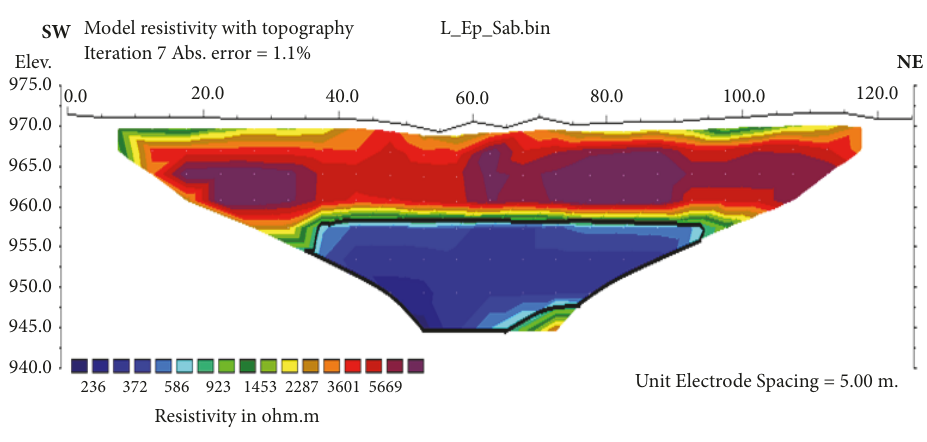
Figure 6: Inverse resistivity model along profile